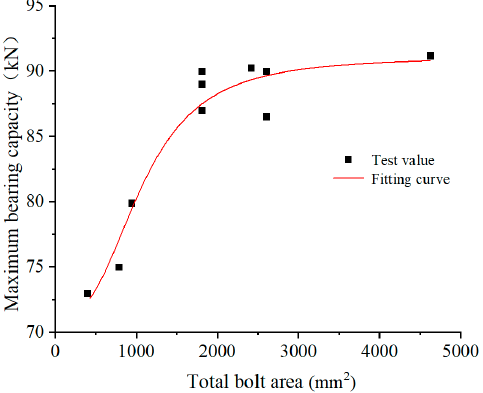
Figure 15. The maximum load capacity vs. total bolt area curve.